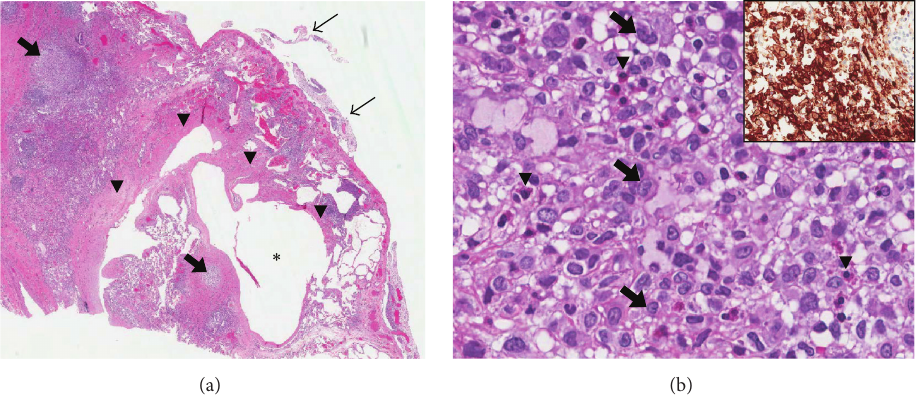
Figure 2: (a) The wedge lung biopsy shows cellular nodules (thick arrows) and an irregular fibrous scar (arrowheads) delimiting a cystically dilated airspace ( ∗ ). Note the flimsy adhesions on the pleural surface, secondary to the pneumothorax (right upper corner, thin arrows)— hematoxylin and eosin stain, 11x. (b) Higher magnification of a cellular nodule reveals numerous histiocytes with folded nuclei (arrows) in an eosinophilic inflammatory background (arrowheads depicting eosinophils)—hematoxylin and eosin stain, 400x. The inset shows strong expression of the immunohistochemical marker CD1a by the histiocytes (brown staining)—CD1a immunohistochemical stain, 110x.